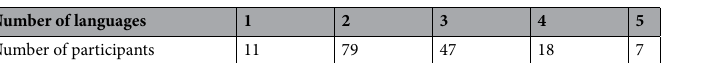
Table 1. Breakdown of participants by number of languages to which they were exposed according to the administered parental language exposure questionnaire.